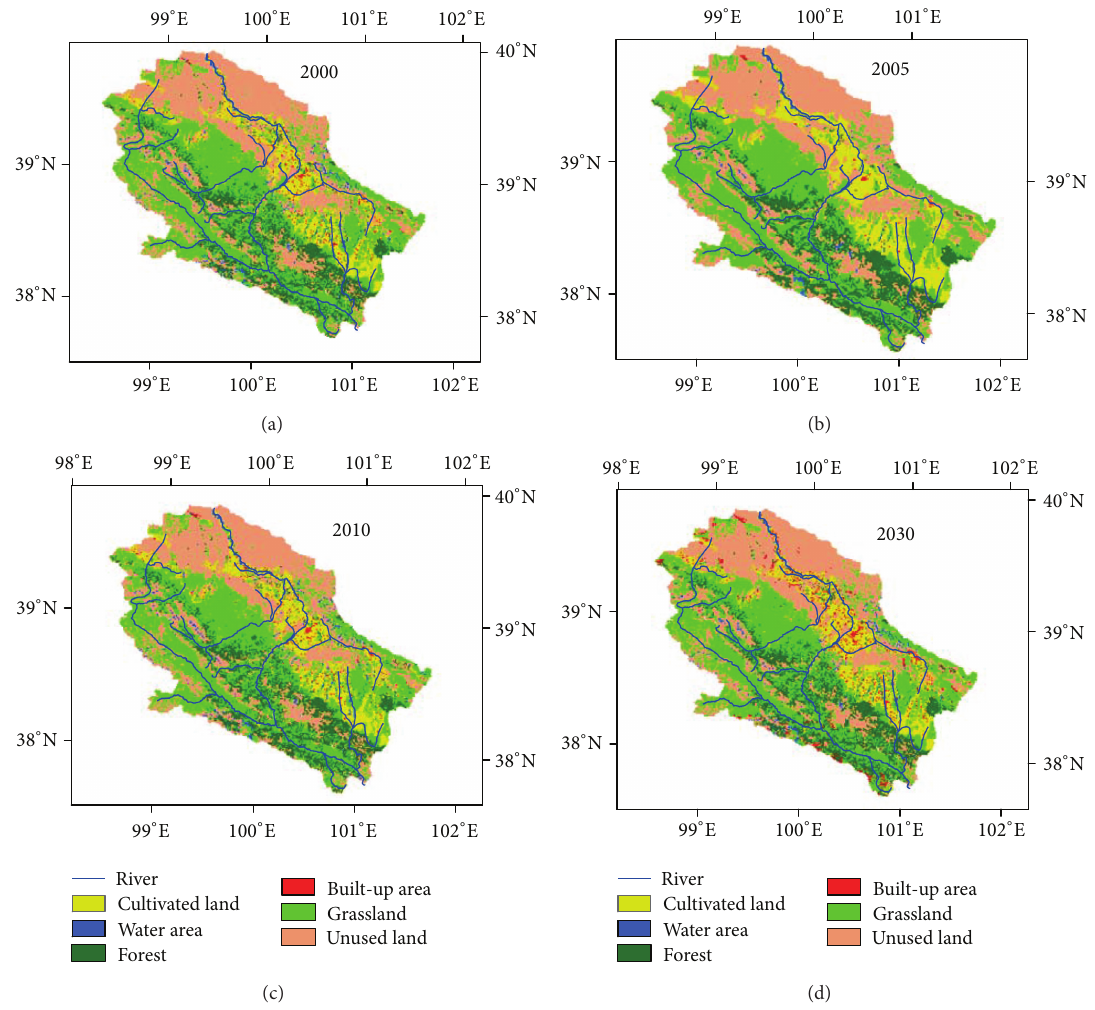
Figure 5: Comparison of the land uses interpreted in 2000, 2005 and simulated in 2010,